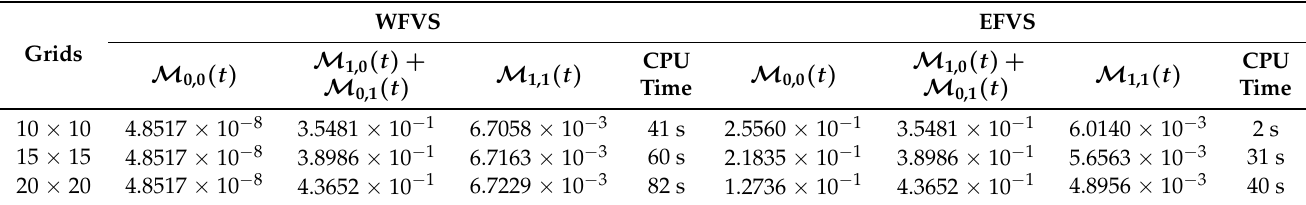
Table 3. Relative error for the weighted moments at different grid points for the test case with S = 1 and breakage functions b 2 at t =